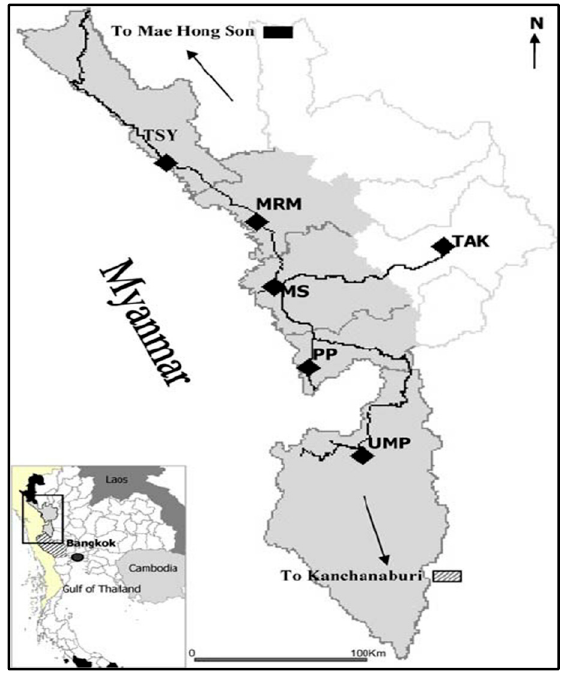
Figure 2. Map of the study area of the M-Fund project. Note: Thai districts along cross border in Tak include MRM = Mae Ramat, MS = Mae Sot, PP = Phop Phra, UMP = Umphang, TSY = Tha Song Yang. Source: https://www.researchgate.net/figure/Map-of-Tak-Province-The-study-area-is-shown-in-grey-DOI_fig1_7062209 (accessed 18 February 2019).